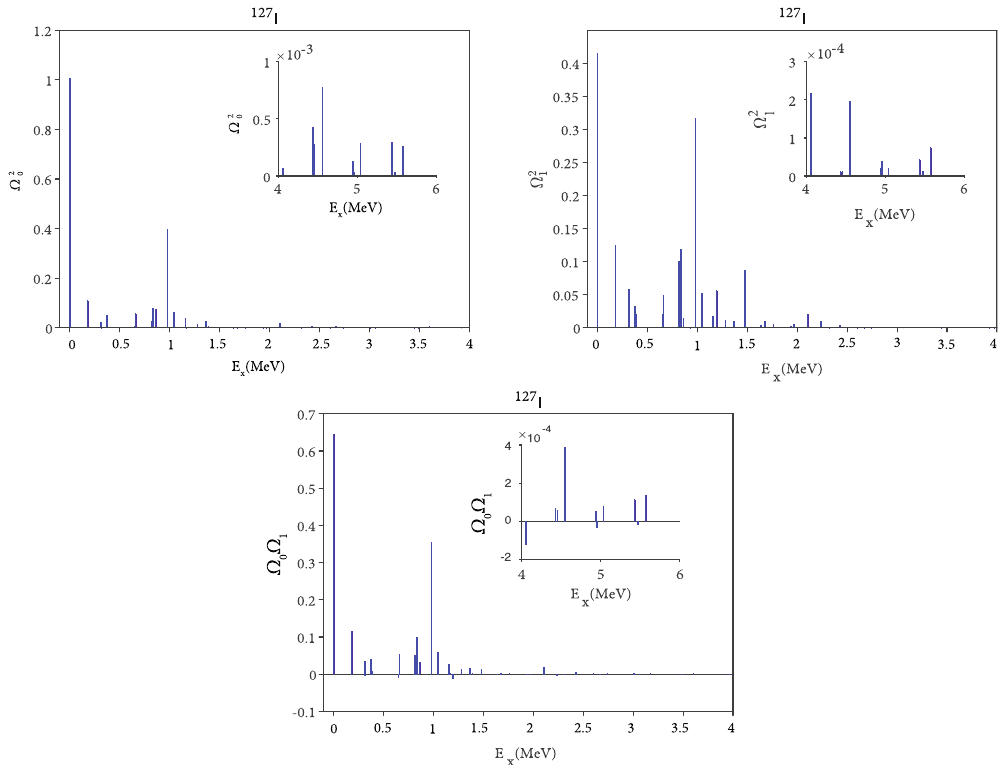
Figure 5: Isoscalar and isovector spin matrix elements up to 6MeV relevant for axion absorption are presented. Note that in the range of 4- 6MeV, in order to make the matrix elements visible, we exhibit them in a separate small window, where the small scale is